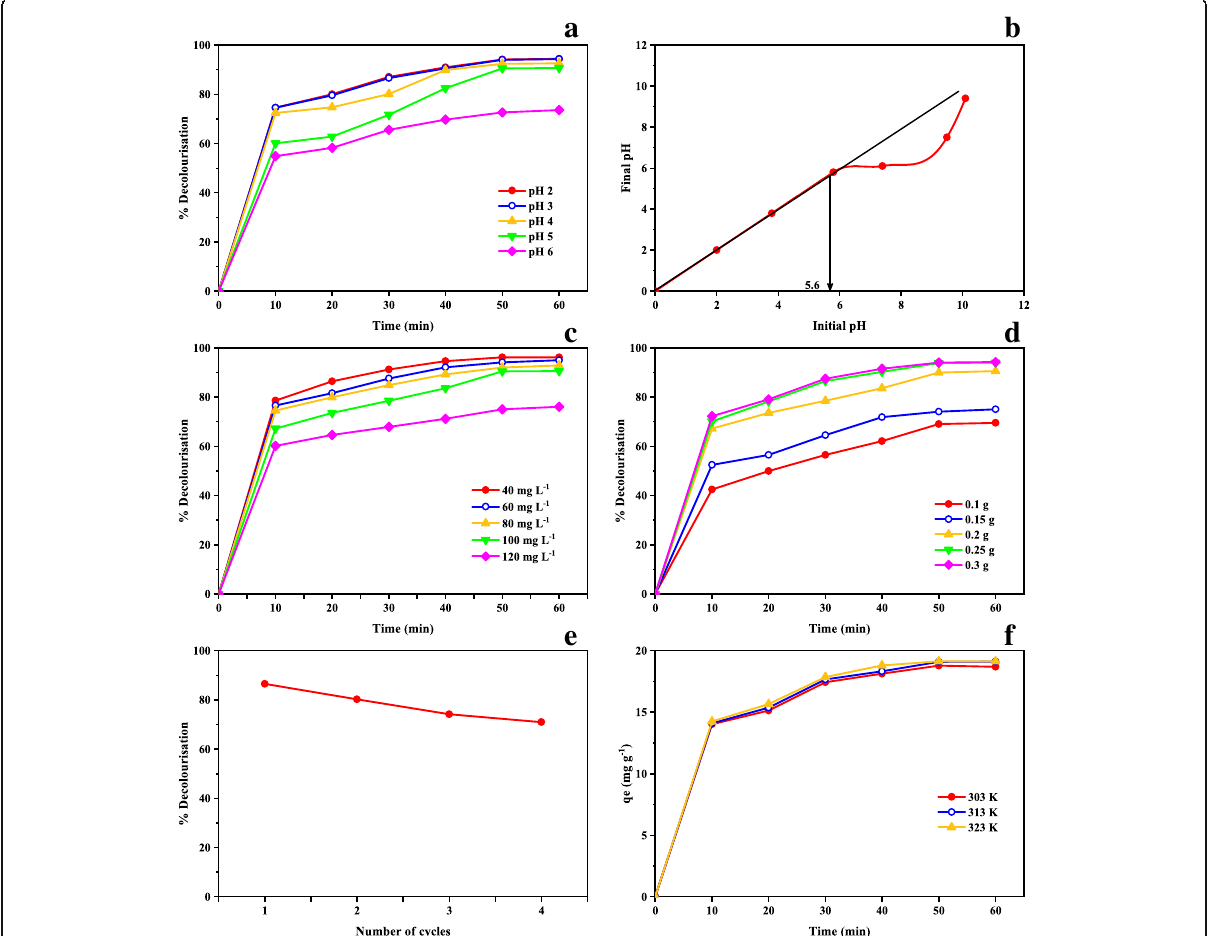
Fig. 4 Effect of operating conditions on % decolourisation of RB-21 on MMCC. ( a ) Effect of pH (Initial concentration-100mgL − 1 , Adsorbent doage- 0.2g, Contact time-60min, Agitation rate-200rpm, Volume-50 mL). ( b ) Influence of initial pH and final pH of point of zero charge (pH zpc ) of MMCC. ( c ) Effect of initial dye concentration and contact time (pH-2, Adsorbent doage-0.2 g, Contact time-60 min, Agitation rate-200rpm, Volume-50mL). ( d ) Effect of adsorbent dose (Initial concentration-100mgL − 1 , pH-2, Contact time-60 min, Agitation rate-200rpm, Volume-50mL). ( e ) Reusability study of adsorbent (pH-2, Adsorbent dosage-0.25 g, Dye concentration-100mgL − 1 , Contact time-50min, Agitation rate-200rpm, Volume-50 mL). ( f ) Effect of temperature (Initial concentration-100 mgL − 1 , Adsorbent doage-0.25g, Contact time-60min, Agitation rate-200rpm, Volume-50